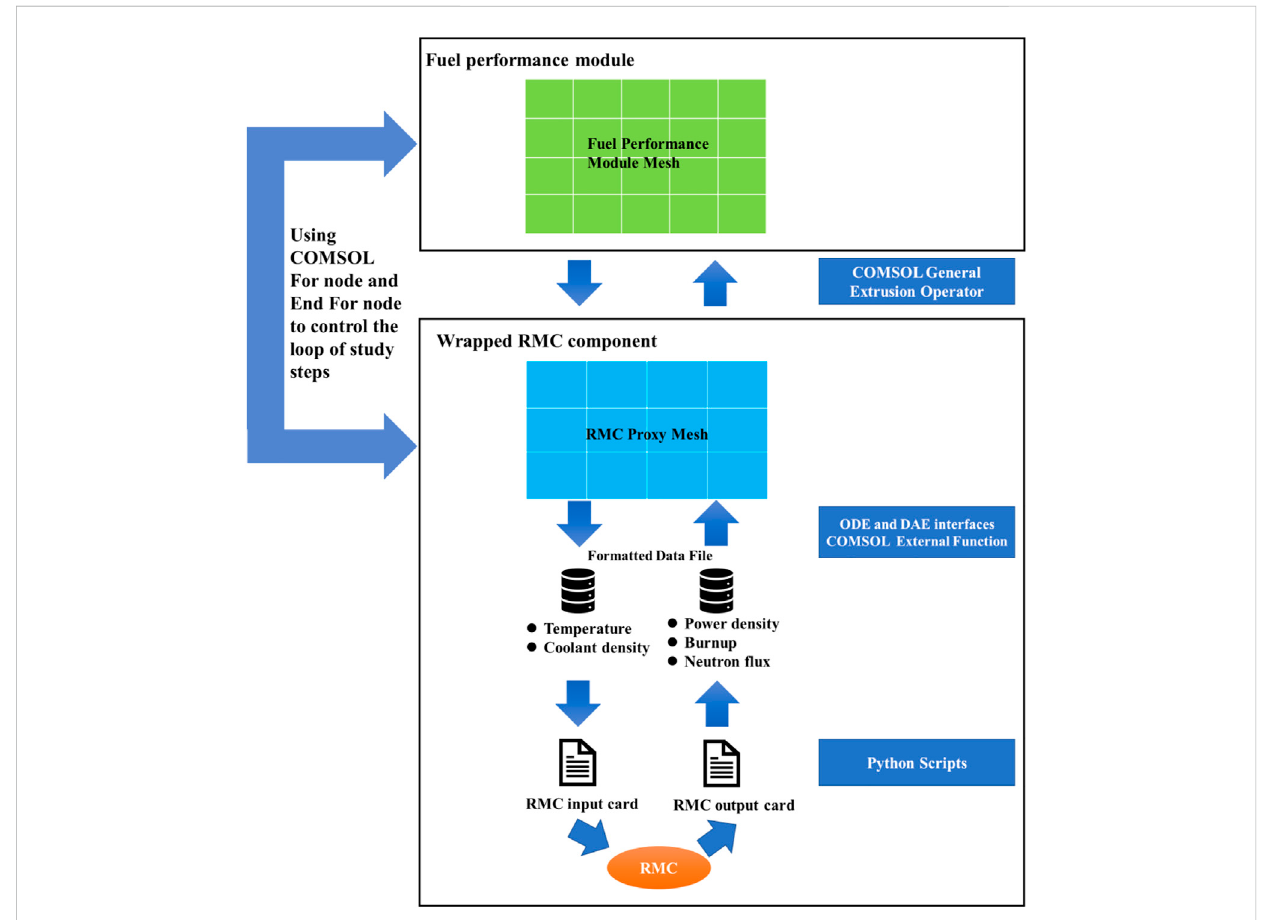
FIGURE 1 Schematic diagram of COMSOL coupling with external code